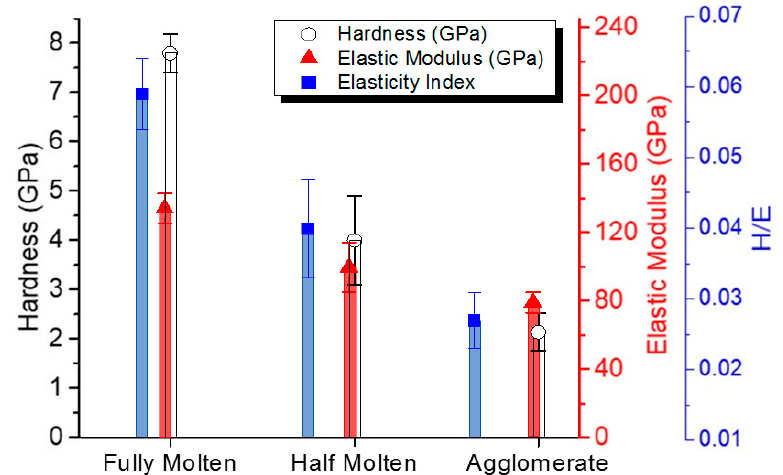
Figure 6. Comparison of nano-indentation results ( H , E and H / E ) on different zones of the suspension HVOF TiO 2 coating (S2).